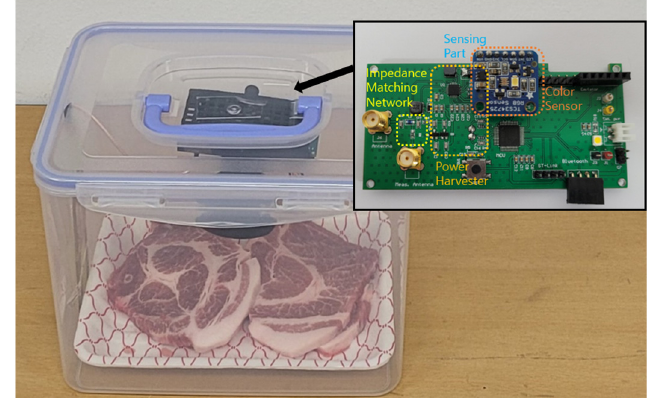
Figure 2. RGB measurement environment for packaged